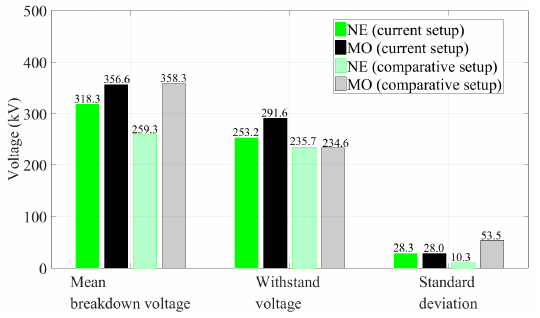
Figure 7. Comparison with results from the former measurement setup in [2] with comparable gap arrangement at positive polarity. Energies 2018 , 11 , x